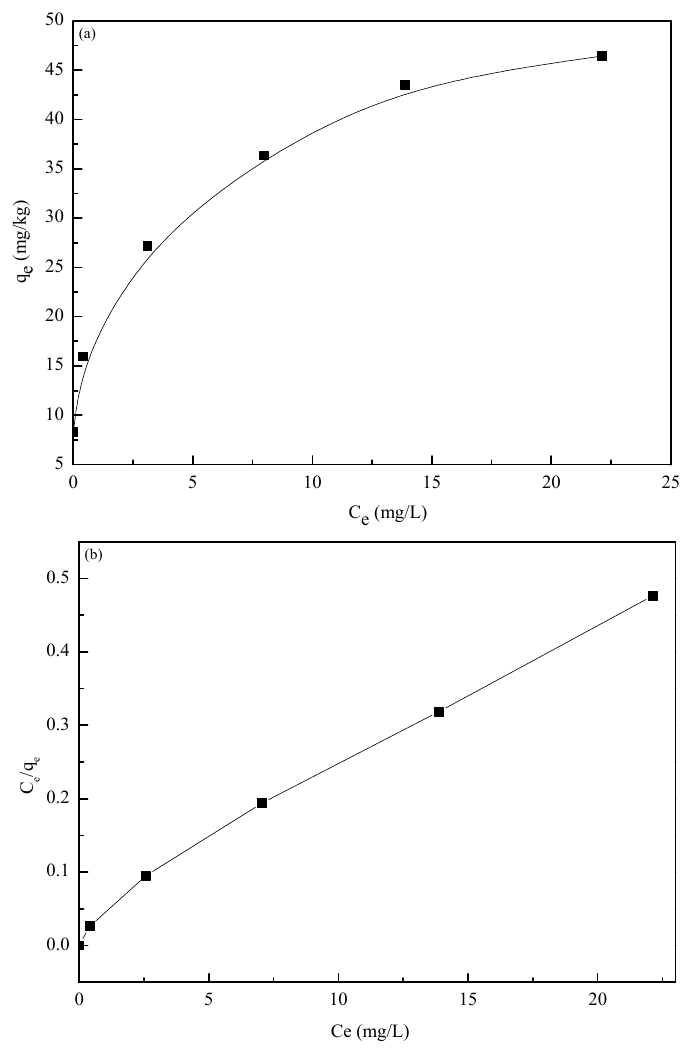
Figure 7. ( a ) Effect of initial concentration on the Cd(II) ions adsorption on nZVI/rGO composites; ( b ) the relationship between C e / q e and C e . (Initial pH = 7.0; nZVI/rGO composites dosage = 30 mg; operating temperature = 20 °C; and contact time = 1 h).